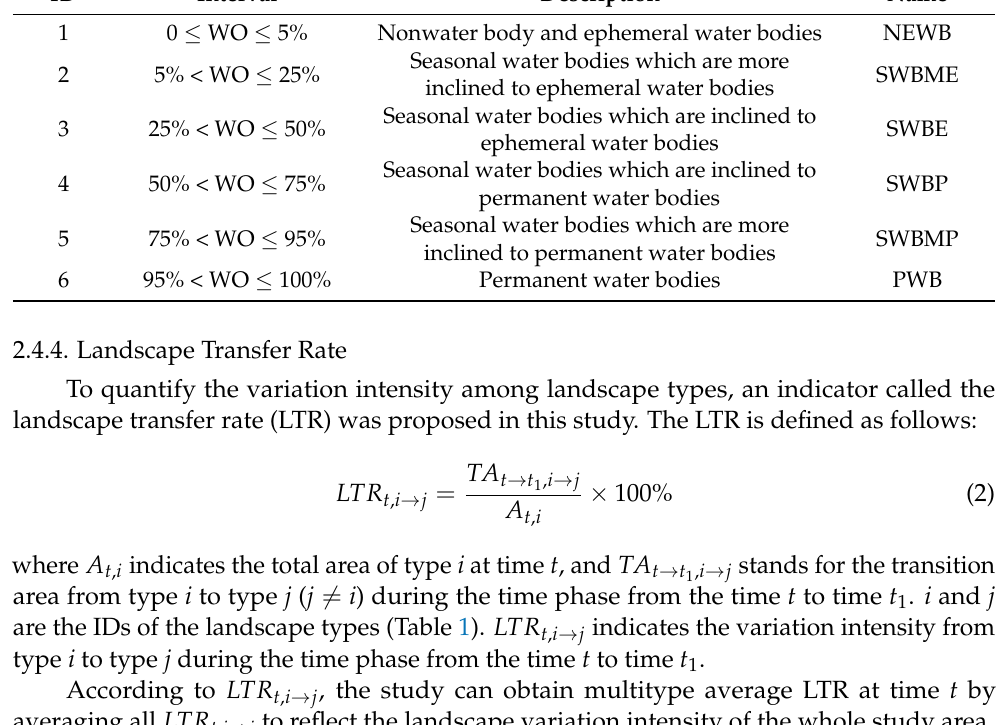
Table 1. Classification of landscape in the study area based on water occurrence. ID Interval Description Name 1 0 ≤ WO ≤ 5% Nonwater body and ephemeral water bodies Seasonal water bodies which are more SWBME inclined to ephemeral water bodies Seasonal water bodies which are inclined to ephemeral water